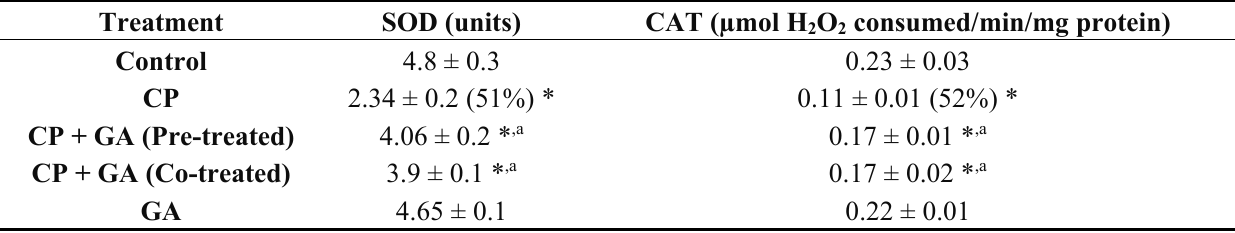
Table 3. Protective effects of gallic acid on cyclophosphamide induced changes in the activities of hepatic superoxide dismutase (SOD) and catalase (CAT) in rats. Treatment